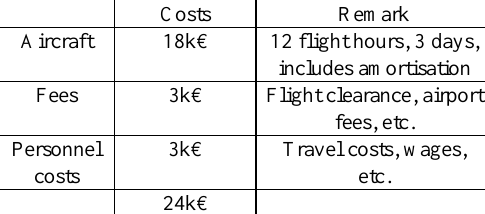
Table 4. Costs for airborne monitoring of three coverages in Hamburg including crews and